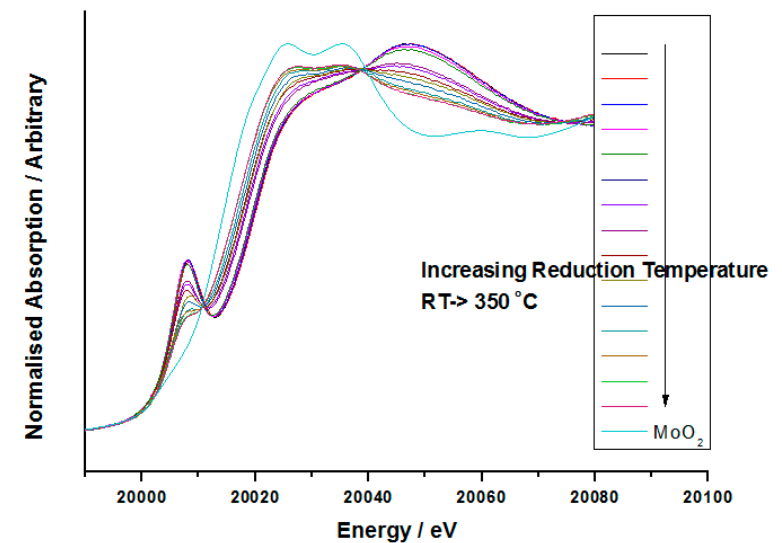
Figure 22. Temperature programmed XAS showing the reduction of 6ML MoO x /Fe 2 O 3 in MeOH/He while heating from ambient temperature to 350 °C, together with MoO 2 reference (pale blue). A shift in the absorption edge, to lower energy is seen with increasing temperature. Image adapted from C. Brookes et al. , Catal. Sci. Technol. , 2016, 6, 722 [35].